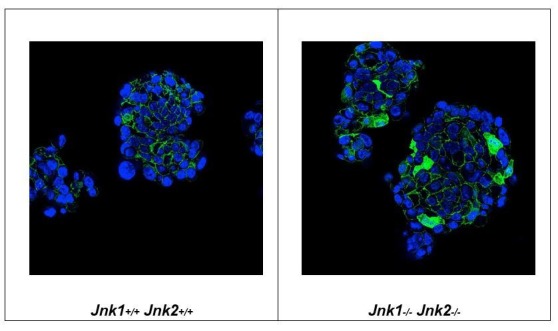
Mammospheres prepared from Control (left panel) and JNK-deficient (right panel) tumor cells were embedded in paraffin, sectioned, and stained with DAPI and an antibody to β-catenin.We found that β-catenin was restricted to the cytoplasm of Control tumor cells, but β-catenin was detected in both the nucleus and cytoplasm of JNK-deficient tumor cells.